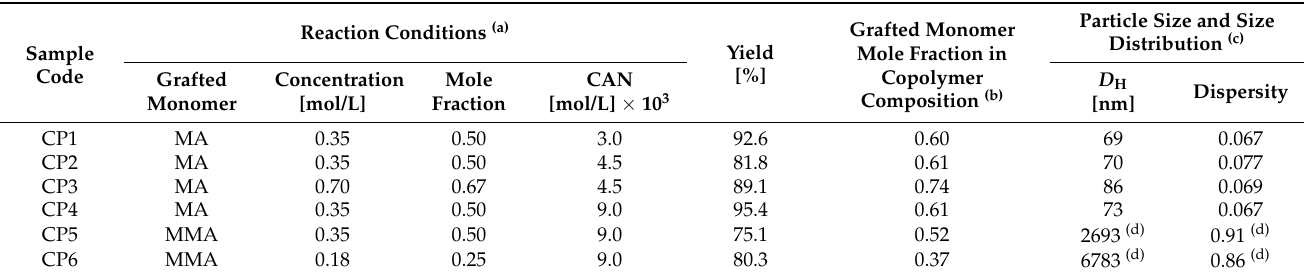
Figure 1. Schematic presentation of the reaction of grafting MA and MMA on PVA. Table 1. Grafting reaction conditions and characteristics of the obtained colloidal particles.